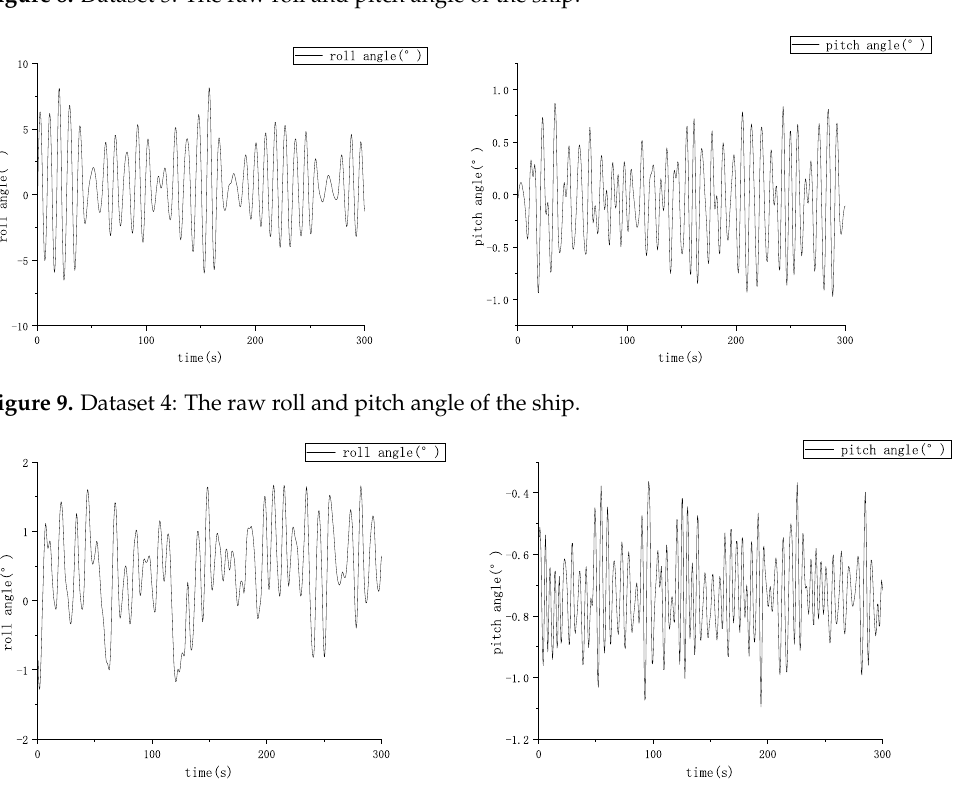
Figure 10. Dataset 5: The raw roll and pitch angle of the